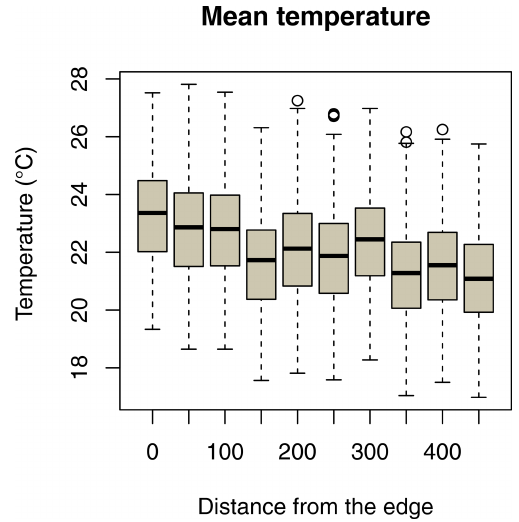
Figure 3. Decrease in daily mean temperatures as a function of the distance of iButton locations from the border of the forest